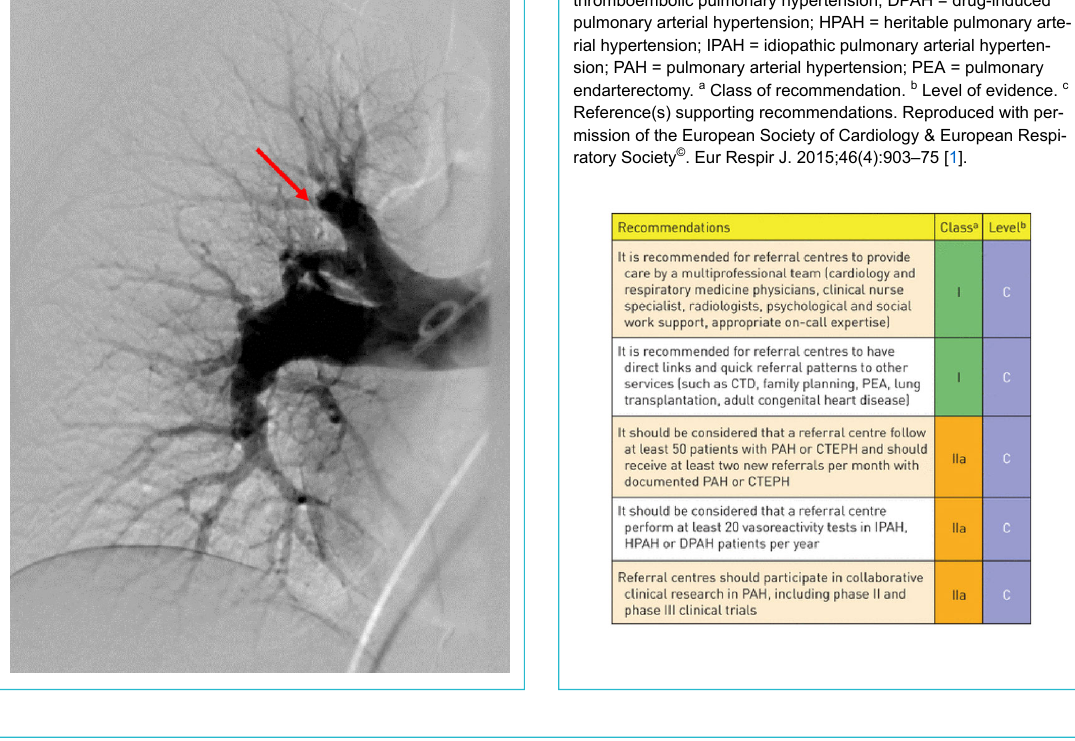
Figure 12: Digital subtraction angiography. Pouch-like ending of pulmonary artery segments (arrow) as well as stenosis and dilated pulmonary arteries are visualised. (Courtesy of Prof. T. Frauen- felder.) Figure 13: Recommendations for pulmonary hypertension referral